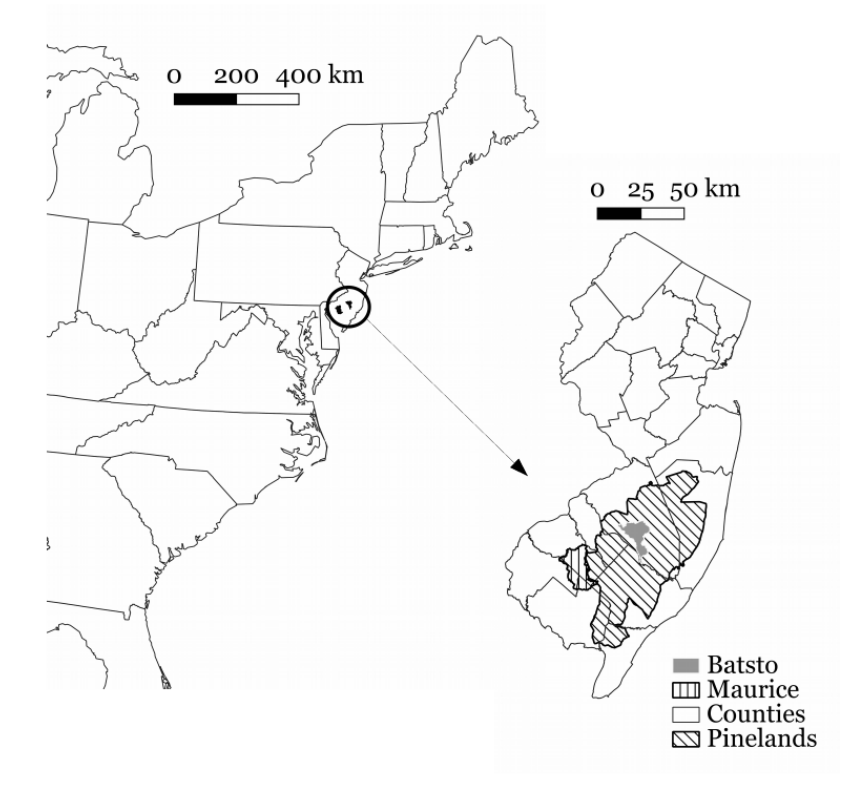
Figure 1. Locations of the Upper Maurice River watershed and the Batsto River watershed. Outlets of each watershed are shown as triangles. The gauge at Norma, NJ, was used for the Maurice River (USGS Site ID 01411500), and the gauge at Batsto, NJ, was used for the Batsto River (Site ID